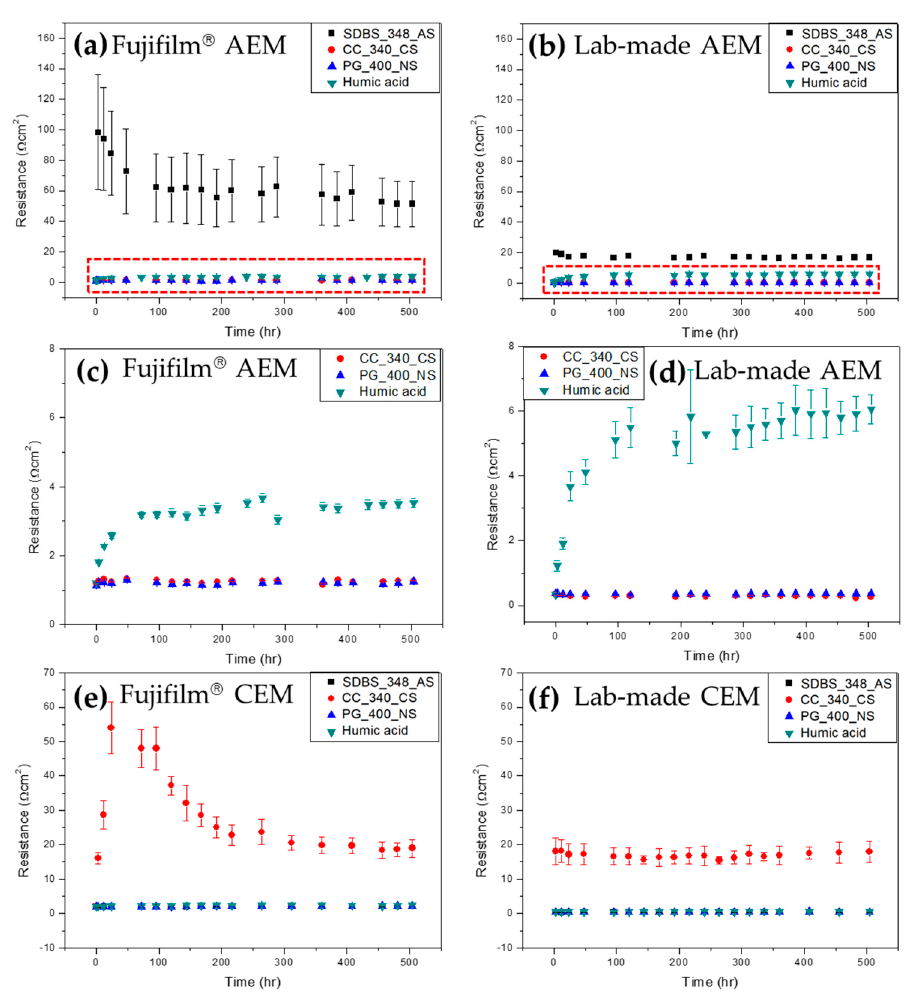
Figure 5. Variation of the electrical resistance of the four different IEMs in the different foulant solutions (SDBS_348_AS, CC_340_CS, PG_400_NS and humic acid): ( a ) Fujifilm ® AEM, ( b ) lab-made AEM, ( c ) the enlarged graph of the red dotted square in ( a ), ( d ) the enlarged graph of the red dotted square in ( b ), ( e ) Fujifilm ® CEM and ( f ) lab-made CEM.